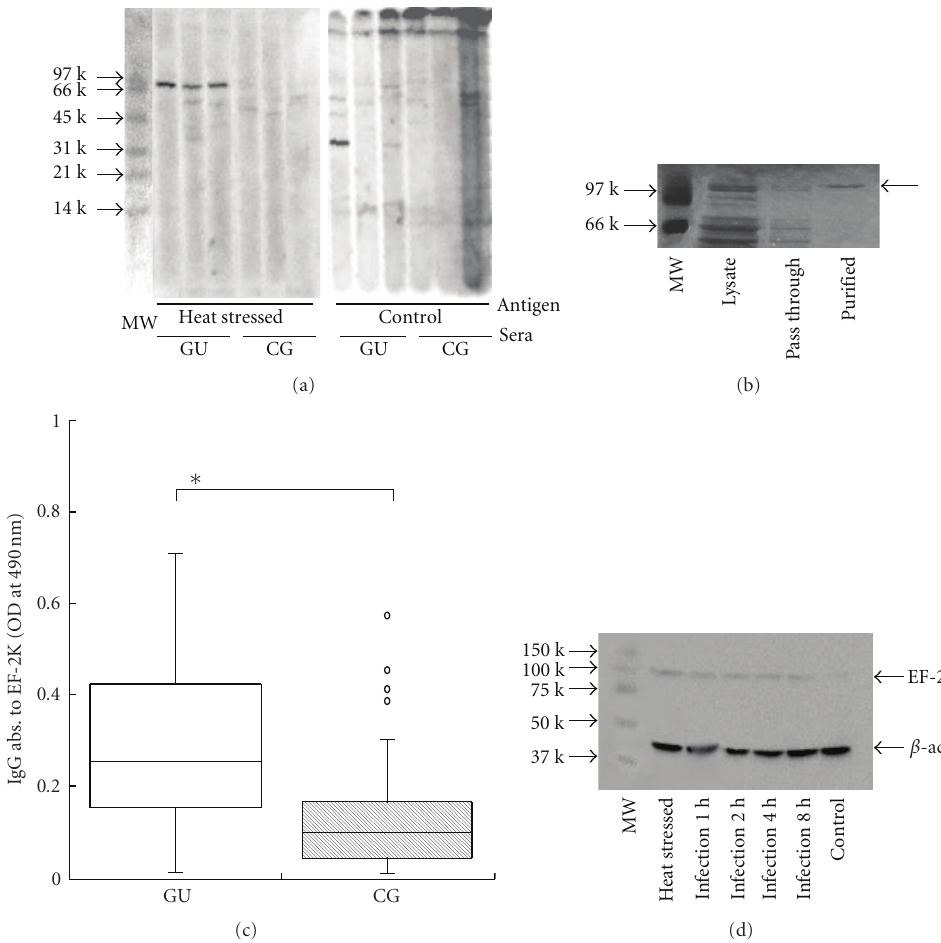
Figure 2: The putative antigen in heat-stressed HGC-27 cells was detected as EF-2K . (a) Western blotting of HGC-27 cells and heat-stressed HGC-27 cells by the sera of GU and CG. Lane 1; molecular weight marker, lanes 2–4; the proteins from heat-stressed HGC-27 cells reacted by GU sera, lanes 5–7; the proteins from heat-stressed HGC-27 cells reacted by CG sera, lanes 8–10; the proteins from nonstressed HGC-27 cells reacted by GU sera, lanes 11–13; the proteins from nonstressed HGC-27 cells reacted by CG sera. 90kDa protein from heat-stressed HGC-27 cells reacted by GU sera specifically. (b) The expression and purification of EF-2K recombinant protein. About 100 kDa protein was purified. (c) Antibody to EF-2K recombinant protein in patients with GU and CG. The titer of anti-EF-2K recombinant protein antibodies in GU was significantly higher than that in CG ( ∗ P < . 05). (d) Quantification of EF-2K expressions in HGC-27 infected by H. pylori . The EF-2K expressions in HGC-27 were enhanced by H. pylori infection as by heat